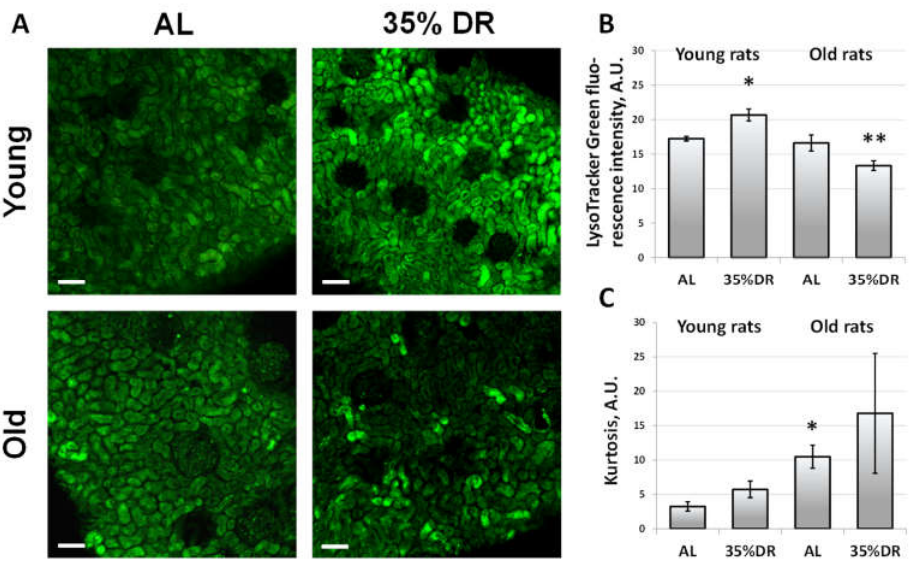
Figure 3. The staining of vital renal cortex slices of young and old rats fed AL or subjected to 35% DR with LysoTracker Green. ( A ) Confocal microscopy after LysoTracker Green staining. The scale bar indicates 100 µm. ( B ) Quantification of LysoTracker Green fluorescence intensity on the vital renal slices of young and old rats; ( C ) Quantification of the coefficient of kurtosis of LysoTracker Green distribution on the vital renal slices of young and old rats. * p < 0.05 compared to the AL group of young rats, ** p < 0.05 compared to the AL group of old rats.